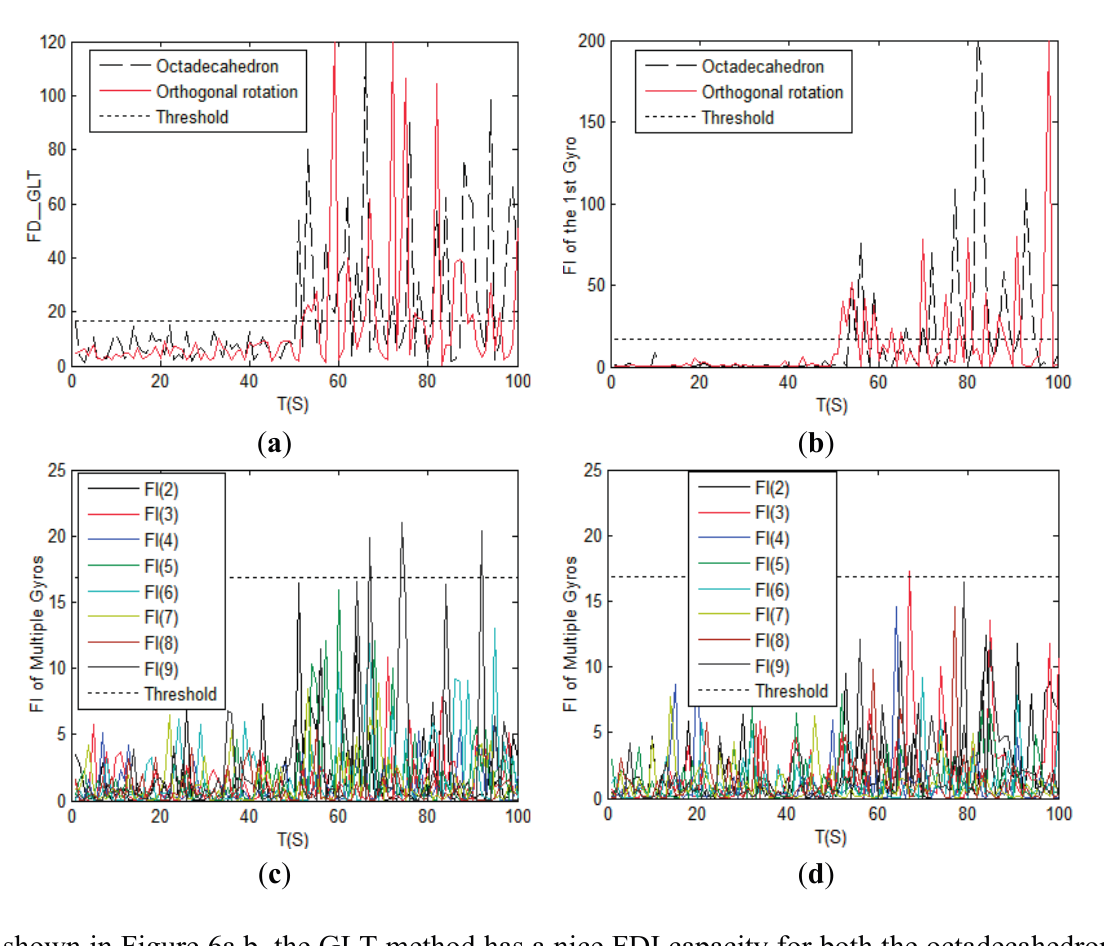
Figure 6. Comparison of single-fault detection and isolation of the octadecahedron and the orthogonal rotation configurations: ( a ) Fault judgment curves; ( b ) Fault detection curves of the 1st gyro; ( c ) Fault detection curves from the 2nd to the 9th gyro of the octadecahedron scheme; ( d ) Fault detection curves from the 2nd to the 9th gyro of the orthogonal rotation